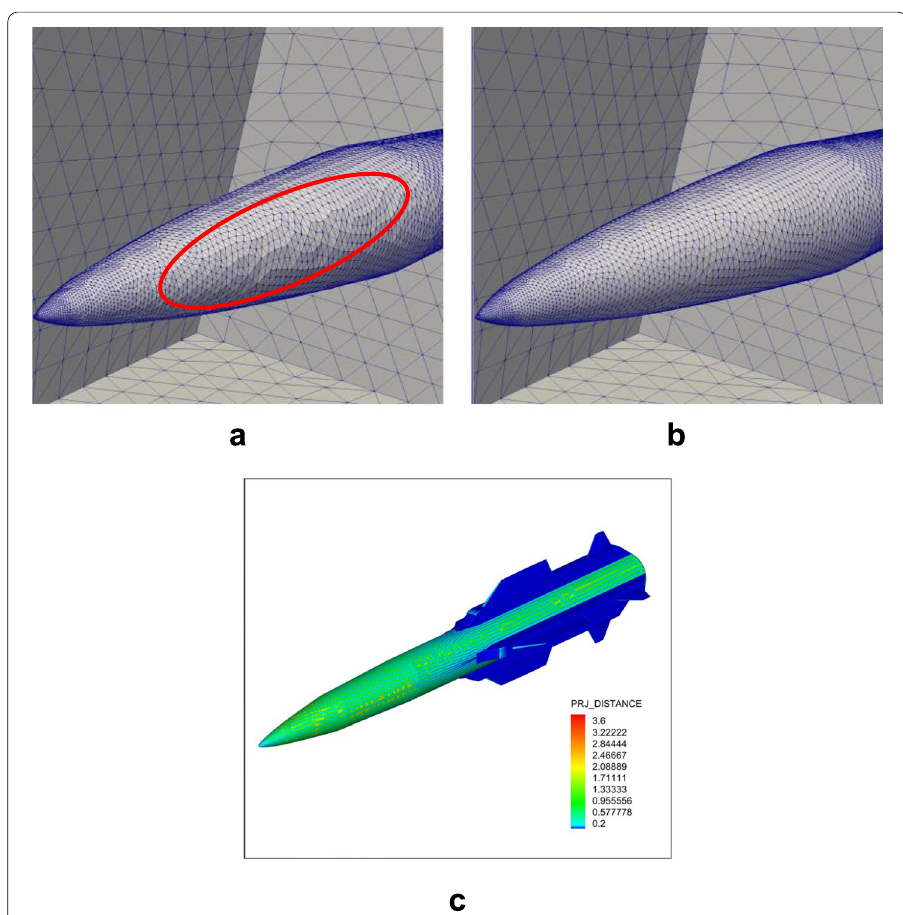
Fig. 11 Comparison of the refinement results with and without the projection step enabled. a is the mesh with this step disabled, b is with this step enabled, and c presents a color map describing how far the mesh ( a ) deviates from the original CAD